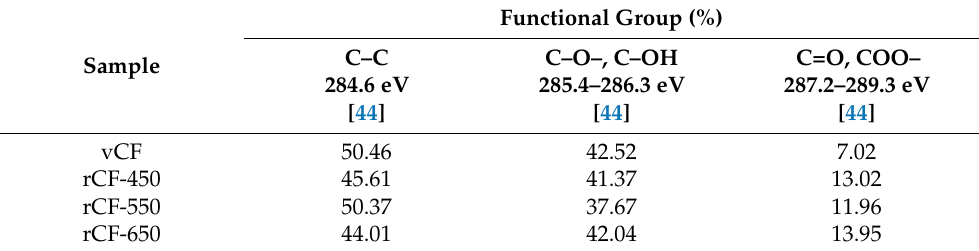
Table 5. The relative contents of functional groups on carbon fibre surface determined by